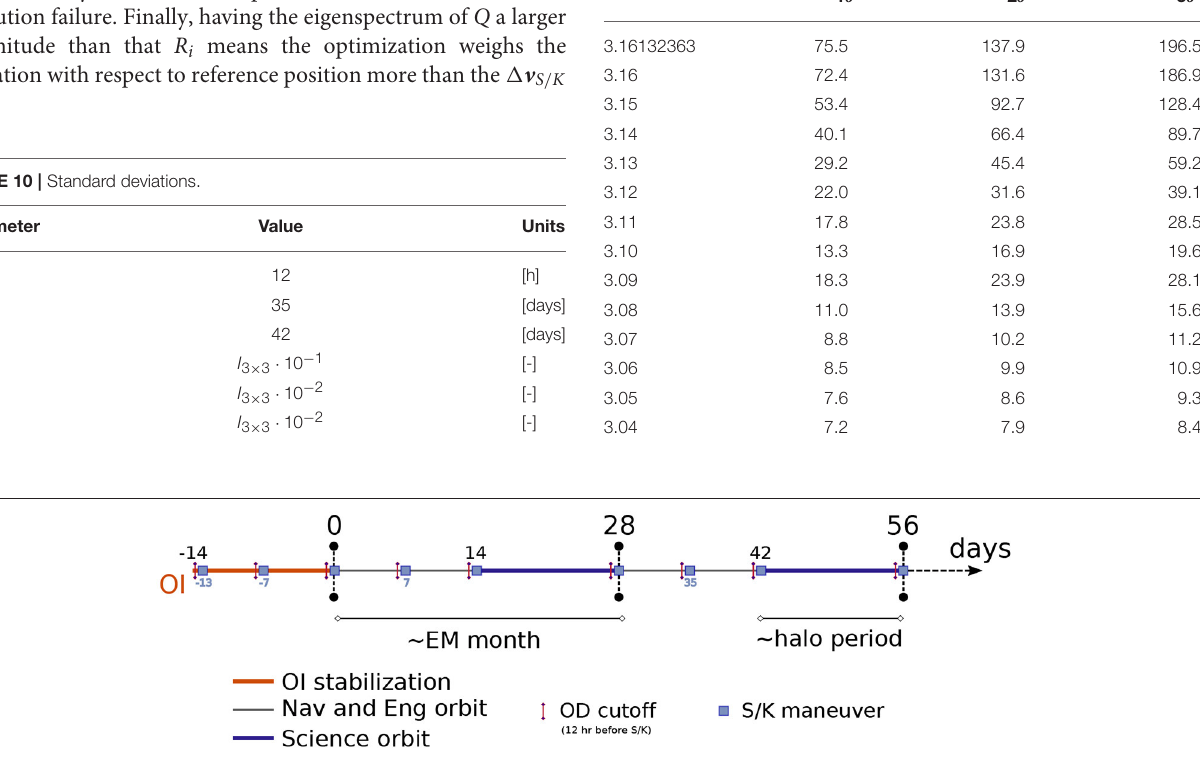
FIGURE 9 | Strategy for station-keeping maneuvers